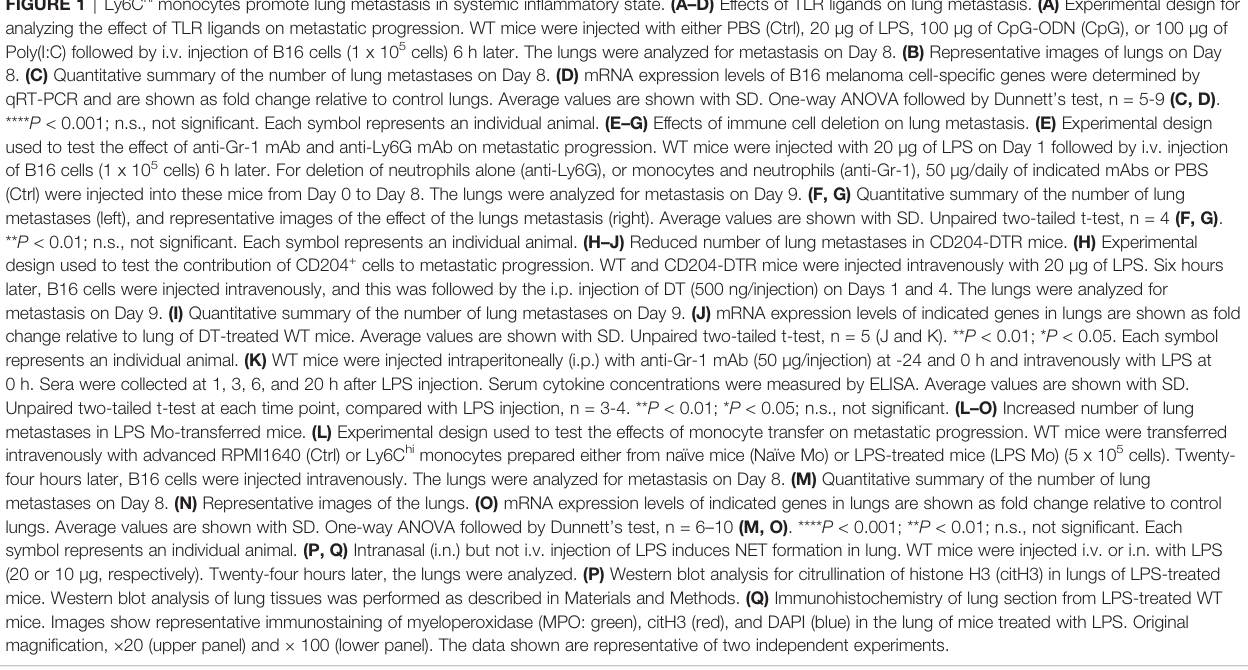
To elucidate the mechanisms underlying the promotion of metastasis by Ym1 + Ly6C hi monocytes, we sought to characterize the Ym1-Venus + Ly6C hi monocyte subpopulation that accumulated in lung during systemic in fl ammation. Flow